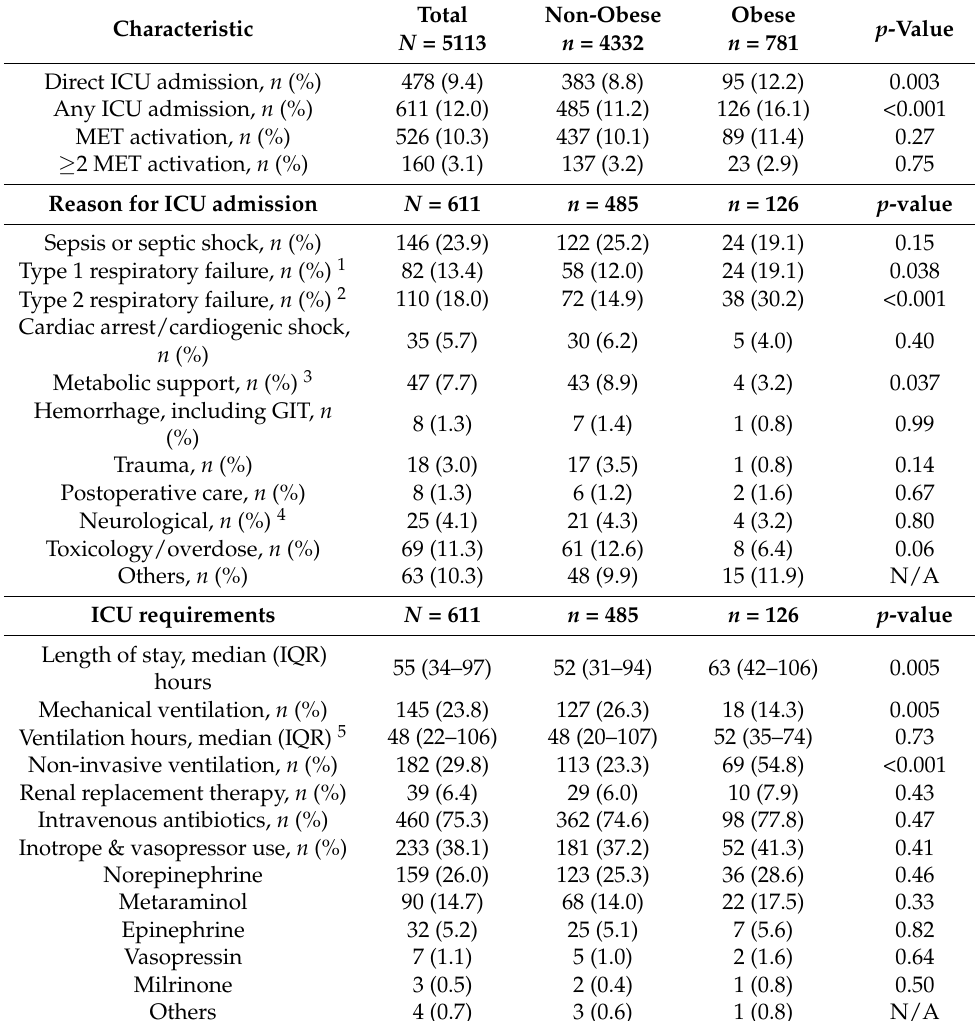
Table 6. Intensive care unit utilization and medical emergency team activation by obesity